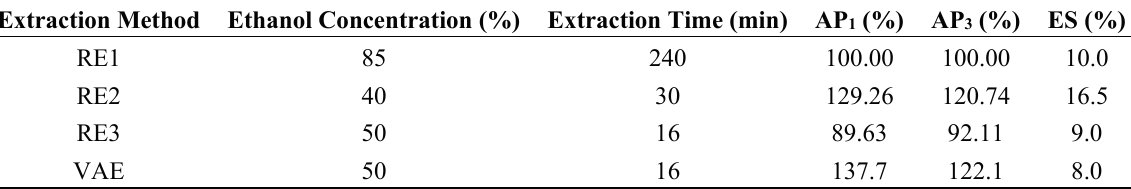
Table 6. Comparison